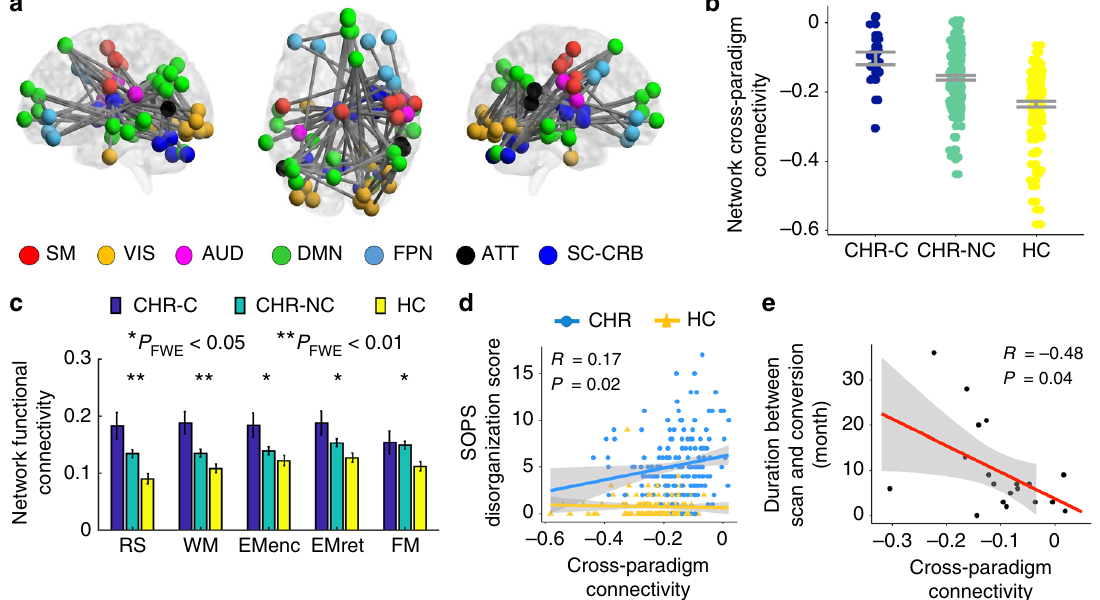
Fig. 2 Network alteration observed in the NAPLS-2 data. a The identi fi ed network with higher connectivity in converters and non-converters compared with controls from the NBS analysis. The nodes in the network mapped to seven functional systems (SM sensorimotor, VIS visual, AUD auditory, DMN default- mode, FPN frontoparietal, ATT attentional, SC-CRB subcortical-cerebellar). b Signi fi cant linear relationship was shown for the mean cross-paradigm connectivity of the identi fi ed network between three groups, with the converter group having the highest value and the control group having the lowest. Note that the cross-paradigm connectivity values were de fi ned at the PCA space, which was rescaled to be mean centered at zero. CHR-C converters, CHR-NC non-converters, HC healthy controls. c The functional connectivity strength of the identi fi ed network in the original connectivity matrices for three groups. Signi fi cant effects were shown for all fi ve paradigms (RS resting state, WM working memory, EMenc episodic memory encoding, EMret episodic memory retrieval, FM emotional face matching). d The mean cross-paradigm connectivity of the network was signi fi cantly correlated with the SOPS disorganization scores in subjects at clinical high risk but not in healthy controls. e The mean cross-paradigm connectivity of the network signi fi cantly predicted time to conversion to psychosis among converters. Error bars indicate standard errors